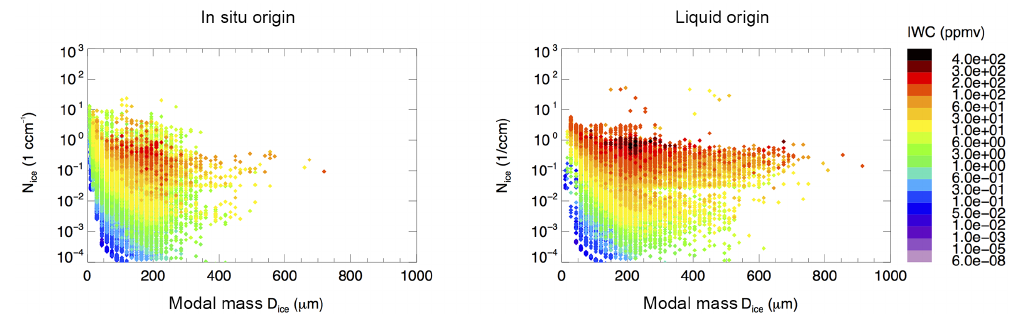
Figure 8. Same as Fig. 7a and b but with D ice, mode instead of R ice